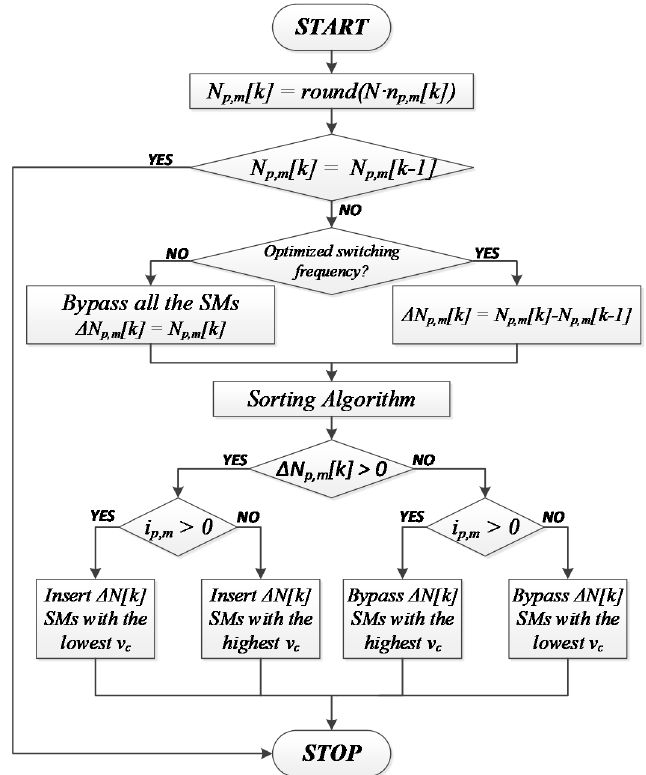
Figure 3. Flowchart of the basic capacitor voltage balancing algorithm in Nearest Level Control (NLC).